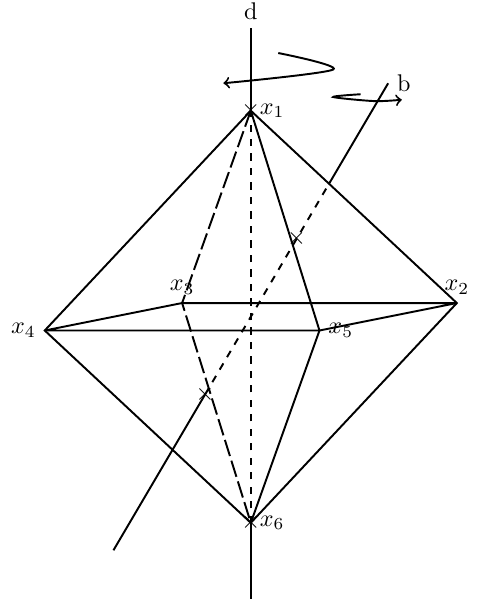
Figure 8. Octahedron and Cube are dual to each other. We parameterize Octahedron similar to the cube, b 3 = d 4 = e , db 2 d = b and dbd = bd 2 b . The six vertices exchange under S 4 as b : x 1 x 2 x 3 x 1 ; x 4 x 5 x 6 x 4 , d : x 1 x 1 ; x 6 x 6 ; x 3 x 2 x 5 x 4 x 3 7! 7! 7! 7! 7! 7! 7! 7! 7! 7! 7! 7!